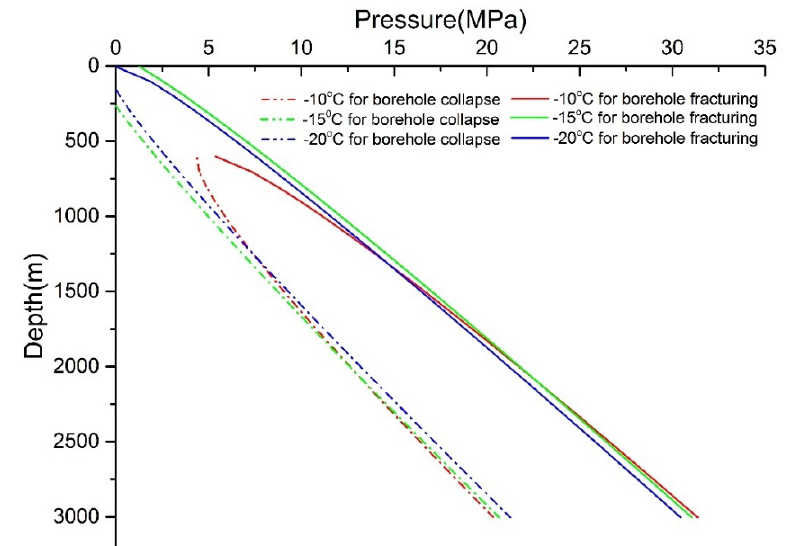
Figure 7. Critical borehole fracturing and collapse pressure changes at different temperatures, as calculated by the Derradji-Aouat criterion.